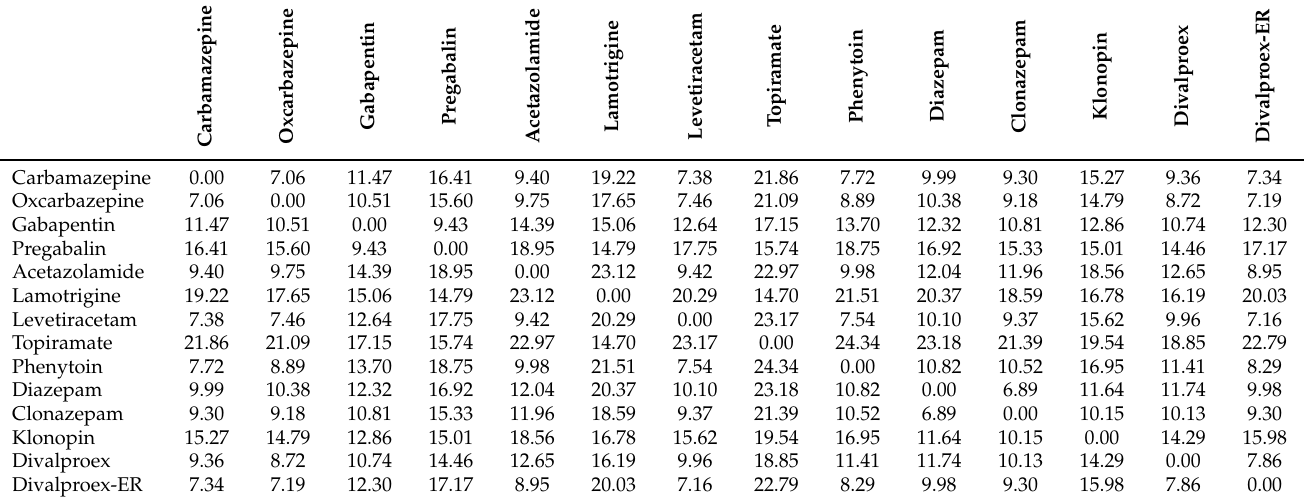
Table 4. AEDs Drug-Drug Similarity using MD Measure.